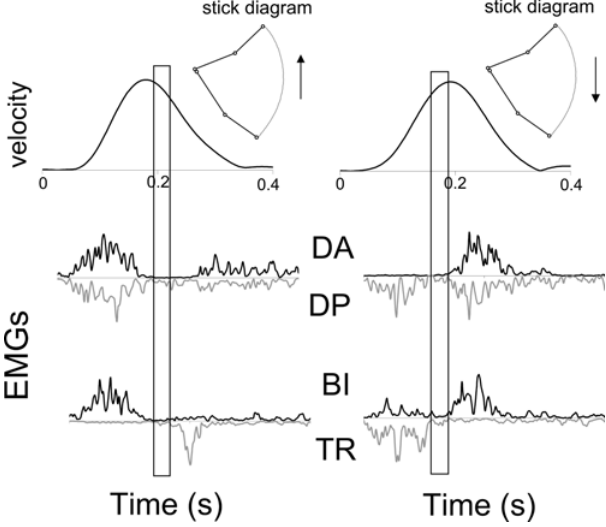
Figure 6. Typical experimental data of a 1-dof arm motion performed in upward (left) and in downward (right) directions. Finger velocity profiles (upper part) and four electromyographic signals (lower part) are reported. Note the asymmetries of the speed profiles and the simultaneous inactivation of all muscles which occurs near the velocity peak. Data are amplitude normalized and the horizontal axis denotes time (in seconds). Same abbreviations than in Figure 3. The same abbreviations as in Figure 3 are used. The appearance of simultaneous inactivation was also checked in movements starting from different initial arm configurations (i.e., starting from various initial arm postures; targets T1-T3 9 and targets T1 9 -T3).